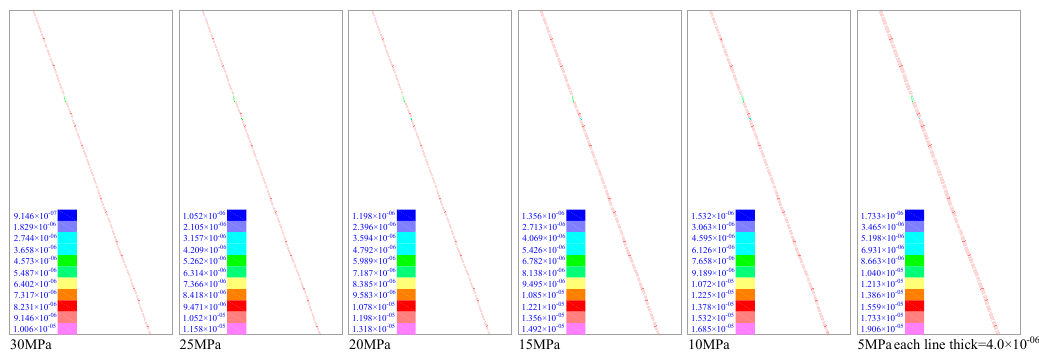
Figure 16. Main seepage channel.